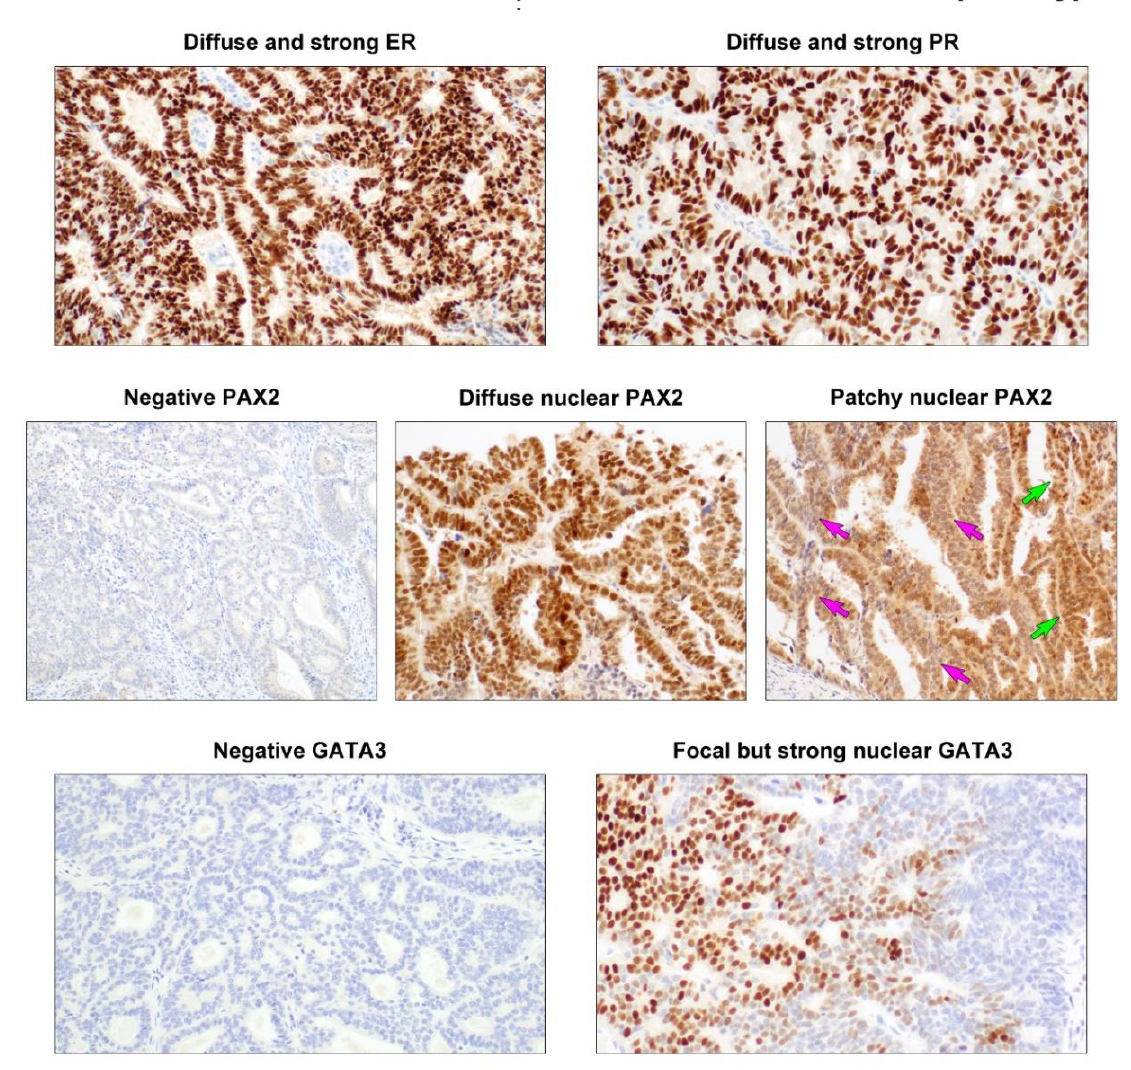
Figure 4. Immunostaining results. ( Upper panels ) The tumor cell nuclei display strongly positive staining for ER and PR. ( Middle panels ) PAX2 immunostaining reveals variable staining proportion: complete absence of expression (negative PAX2) and diffuse or patchy positivity. The green arrows indicate the tumor cells showing strong nuclear PAX2 expression, while those indicated by the pink arrows display weak-to-moderate cytoplasmic immunoreactivity. ( Lower panels ) Similar to PAX2 expression status, the majority of the tumor cells are negative for GATA3, but a small number of compactly aggregated tubules react strongly with